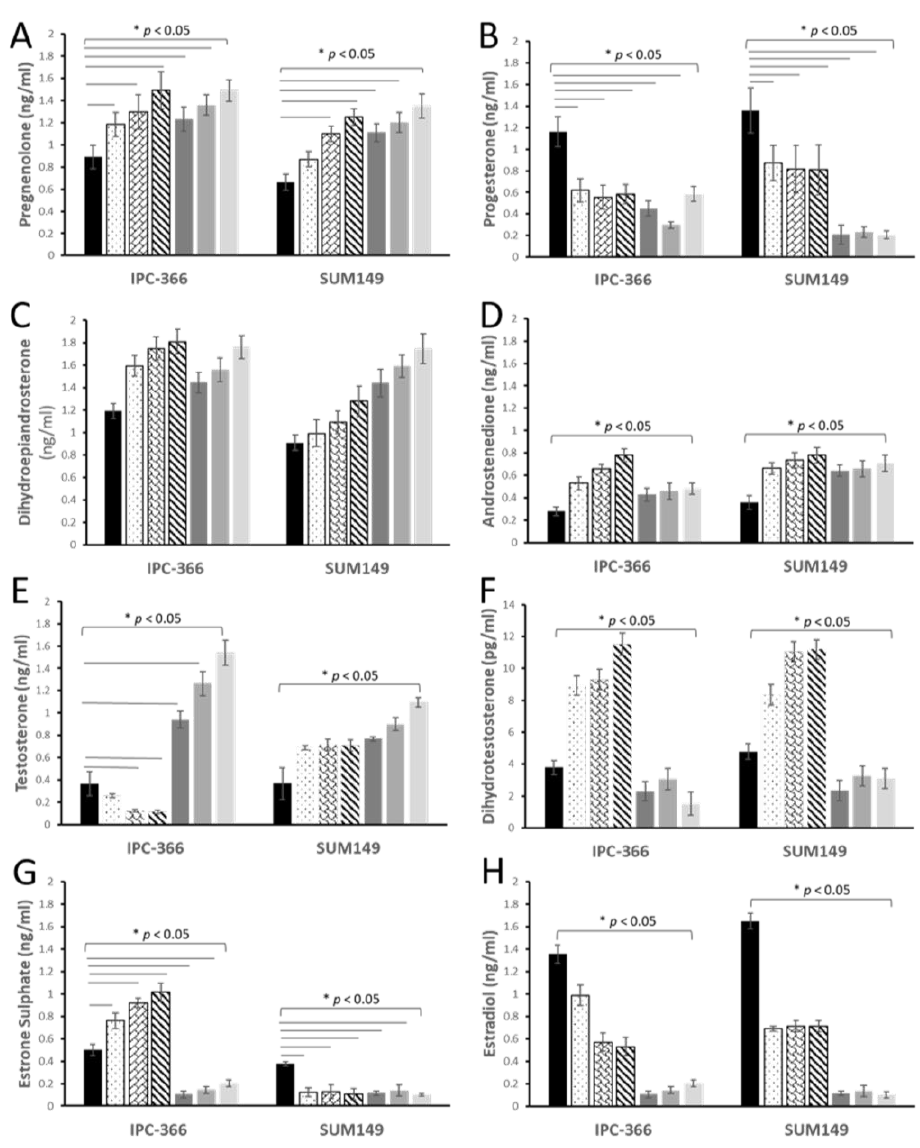
Figure 2. Steroid hormone concentrations of ( A ) P5; ( B ) P4; ( C ) DHEA; ( D ) A4; ( E ) T; ( F ) DHT; ( G ) E1SO4 and ( H ) E2 in culture media of IPC-366 and SUM149 cells treated with different doses of letrozole and STX-64. Culture media was collected 72h after treatment. * denoted significant differences ( p < 0.05) between control and treatments.